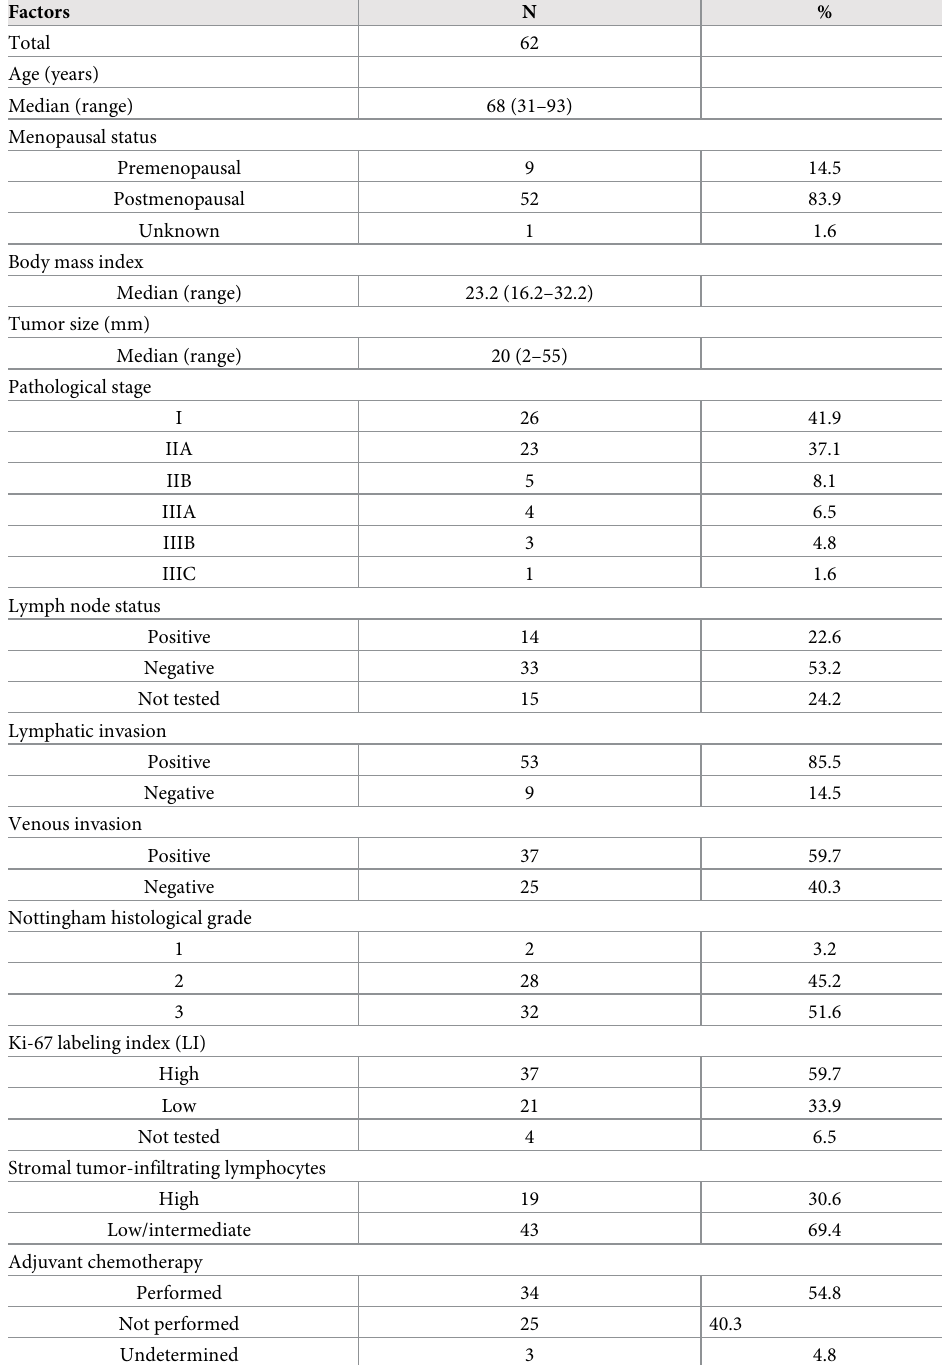
Table 1. Clinical characteristics of patients with triple-negative breast